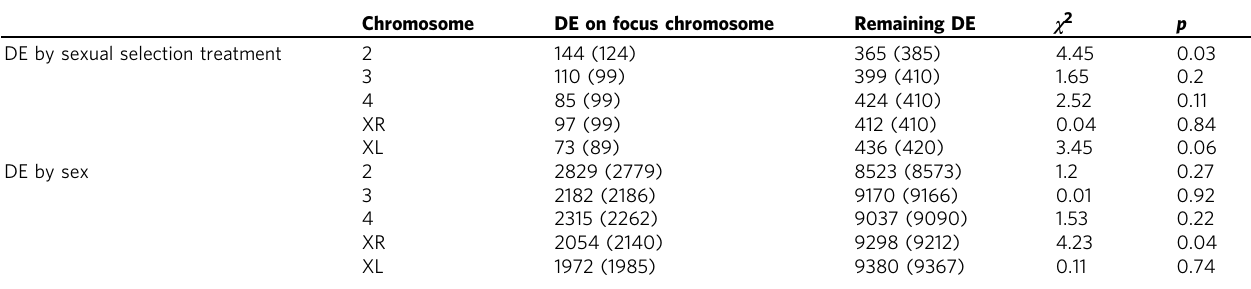
Table 4 Chromosomal distribution of genes which are DE (FDR 10%) following mating system manipulation (679 genes), and by sex (11845 genes), in any